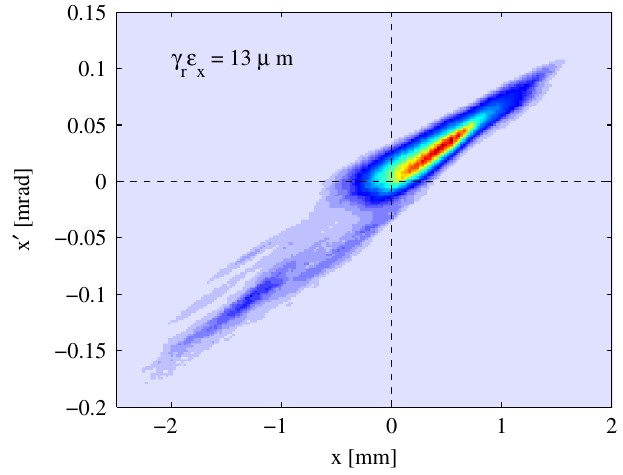
FIG. 14. (Color) Tomographic reconstruction of the horizontal phase space distribution of a compressed bunch, averaged over the entire bunch length. The intersection of the dashed lines defines the charge centroid (energy E ¼ 494 MeV , bunch charge Q ¼ 0 : 72 nC ).